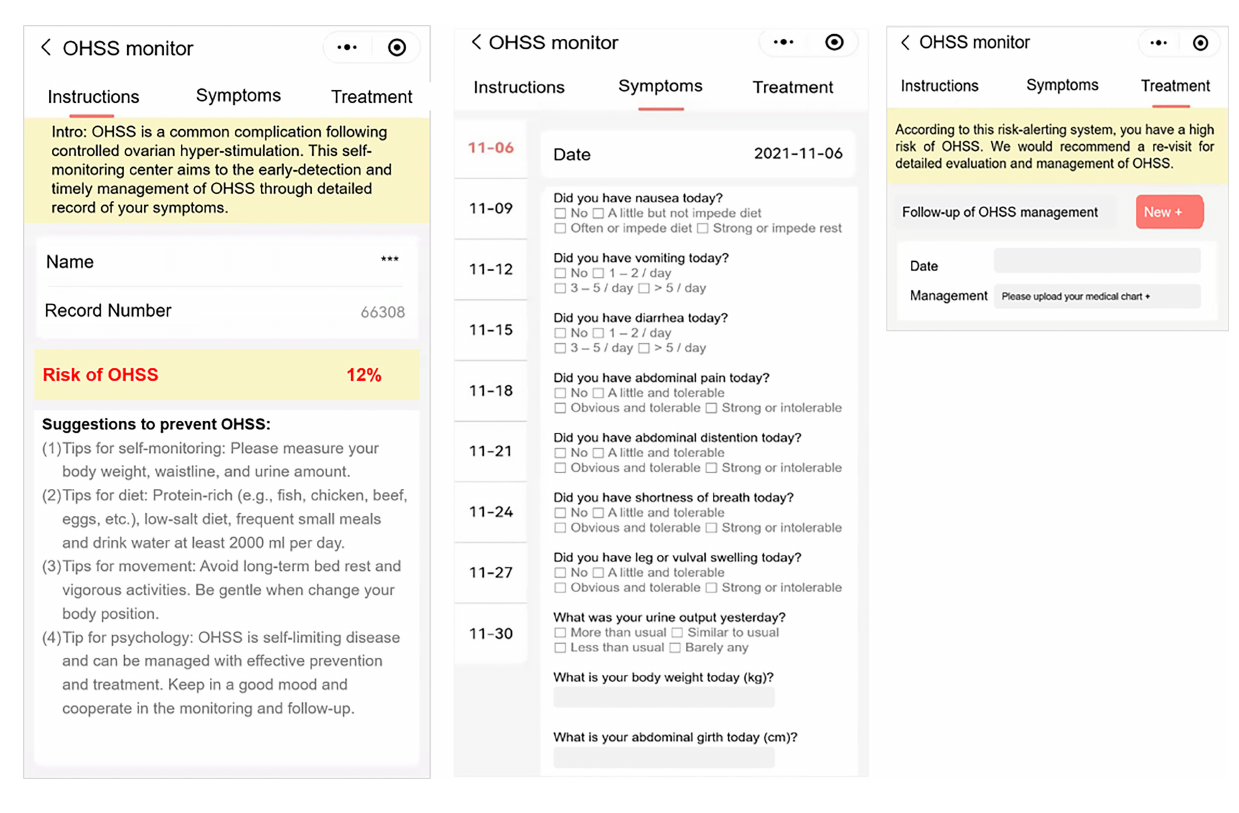
FIGURE 4 | Screenshot of the “ OHSS monitor ” app from a patient ’ s